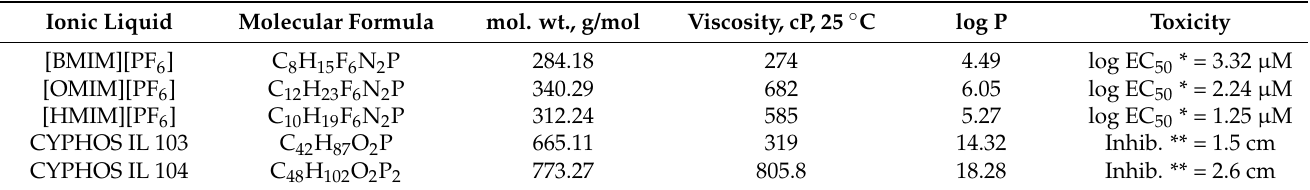
Table 1. Main ionic liquids’ physical properties used in biosynthetic compounds extraction [21,36,37]. Ionic Liquid